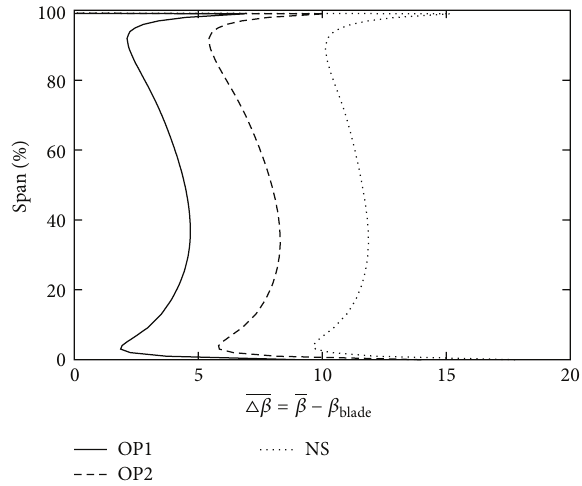
Figure 3: Pressure ratio of the compressor stage. Figure 4: Time-averaged axisymmetric profile from hub to shroud of the incidence angle at the impeller